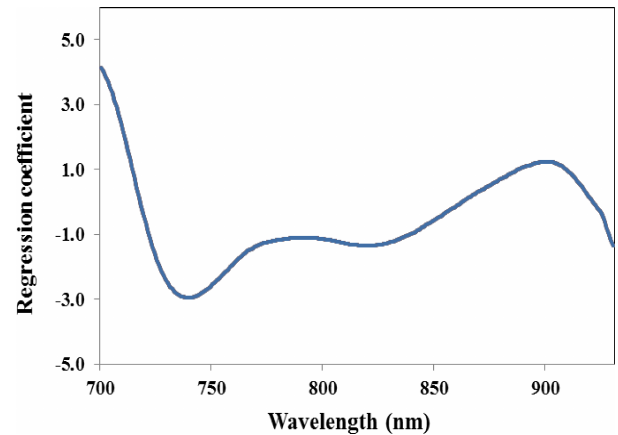
Fig. 10. Regression coe±cient plots for PSLDA model.